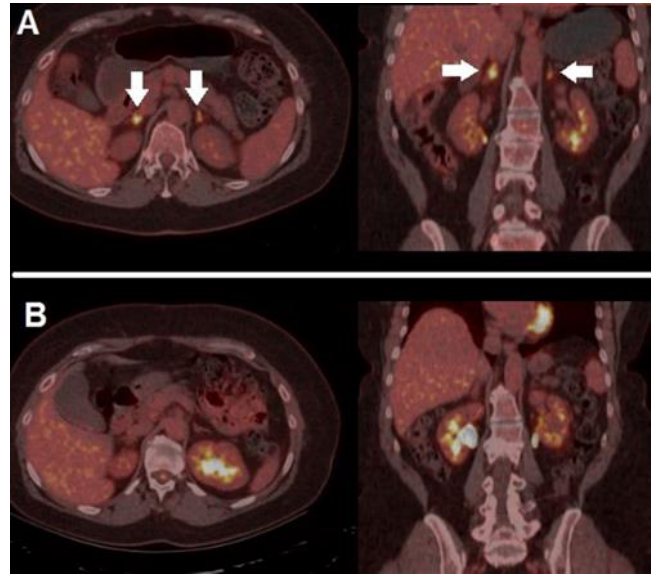
Figure 4. A case of irAEs. A 41-year-old female, previously submitted to excision of a nodular, high-risk MM, started adjuvant immunotherapy with nivolumab. After 4 cycles, she presented mild fatigue and grade 1 hyponatremia and orthostatic hypotension, with reduced level of morning cortisol. 18 F-FDG PET/CT performed after symptoms’ onset ( A ) demonstrated bilateral increased tracer accumulation within adrenal glands (white arrows), compatible with the suspicion of immune-related adrenalitis, she discontinued immunotherapy and started on steroid therapy with excellent clinical response. PET/CT, acquired after steroid therapy and symptoms’ regression ( B ), revealed complete regression of the adrenal glands’ hypermetabolism. After multi disciplinary consensus meeting, immunotherapy was restarted, and no further complications were registered. Table 4. Summary of main studies on 18 F-FDG PET/CT for response assessment to immunotherapy with ICIs in MM.